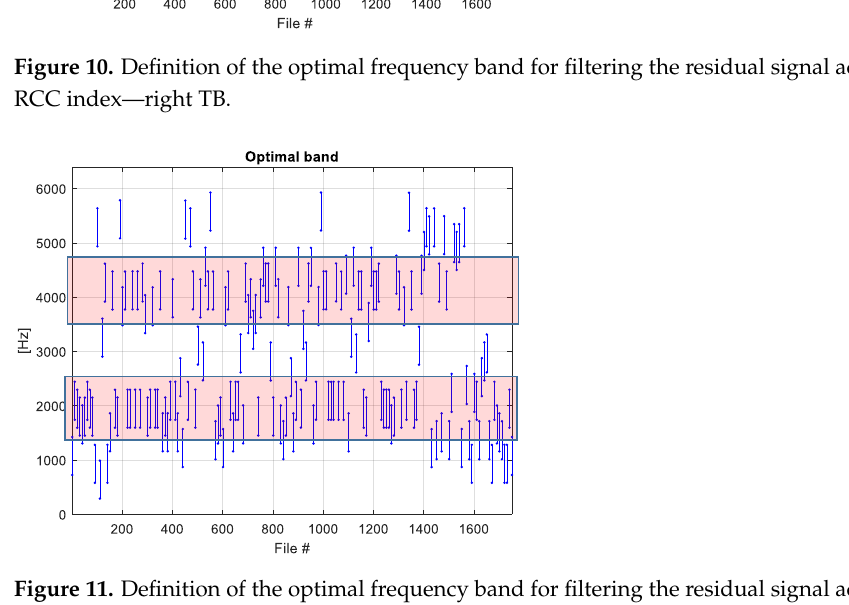
Figure 11. Definition of the optimal frequency band for filtering the residual signal according to the SES index—right TB.